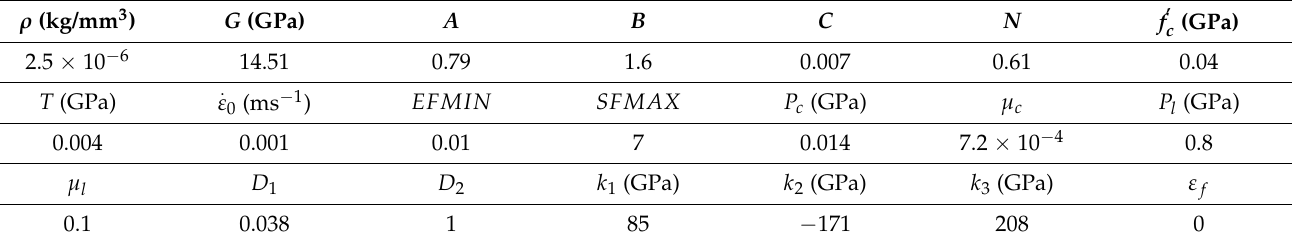
Table 1. Material parameters of HJC constitutive model.